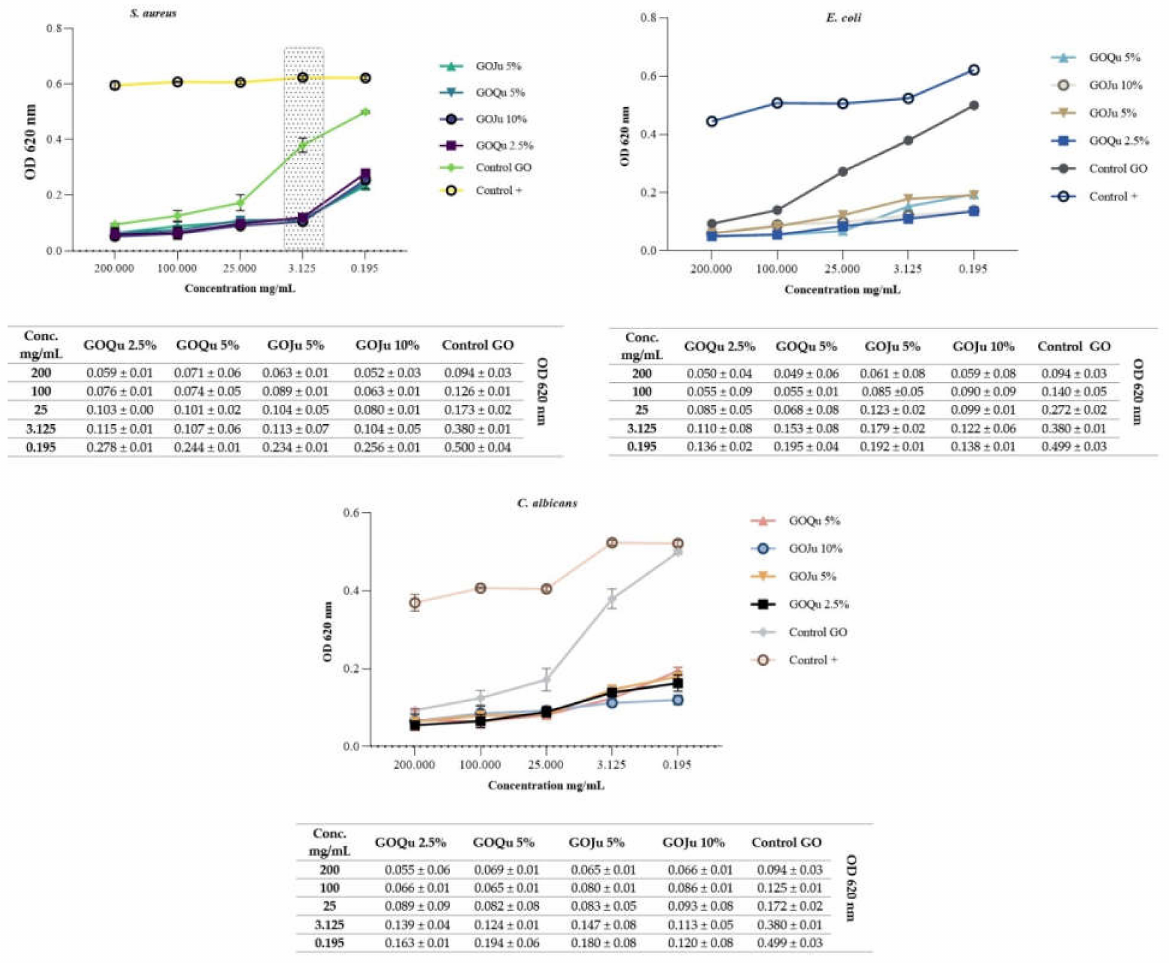
Figure 9. Trendline of antimicrobial susceptibility concentrations of samples GOQu 5% ( w / v ), GOQu 2.5% ( w / v ), GOJu 10% ( w / v ), and GOJu 5% ( w / v ). Control + represents the microbial strains with no